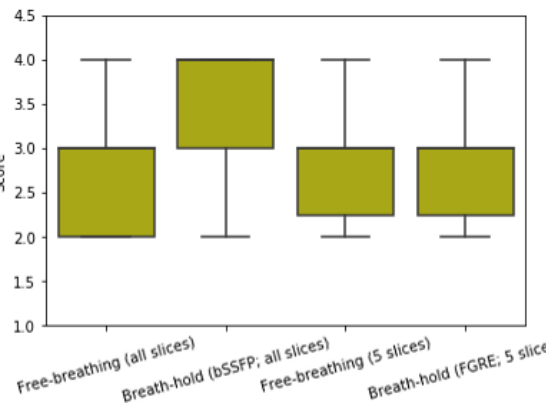
Figure 6. Comparison of image quality of the free-breathing images and breath-hold images. Image quality assessment is done in a blinded fashion by two medical experts. We reconstructed all the short-axis slices acquired from five subjects. We also acquired the fully-sampled breath-hold images for all the slices using the bSSFP sequence. For each subject, we scanned one middle slice using the product FGRE sequence provided by GE HealthCare. The free-breathing images from all the slices received an average score of 2.7, and the clinical fully-sampled images using the bSSFP sequence got an average score of 3.6. The fully-sampled breath-hold images acquired using the FGRE sequence received an average score of 2.9, and the free-breathing images corresponding to these five slices got an average score of 2.8. From which we can see that the reconstructed free-breathing images have similar image quality as the fully-sampled breath-hold images acquired using the product FGRE sequence, even though the images were highly undersampled and acquired in a free-breathing and ungated